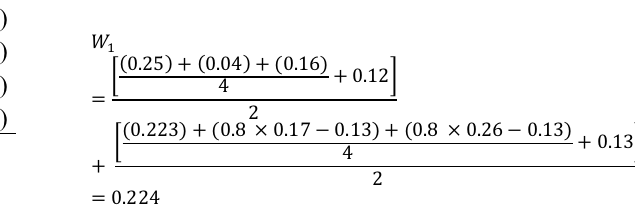
Table 7: Geometric means of each row Fuzzy Geometric